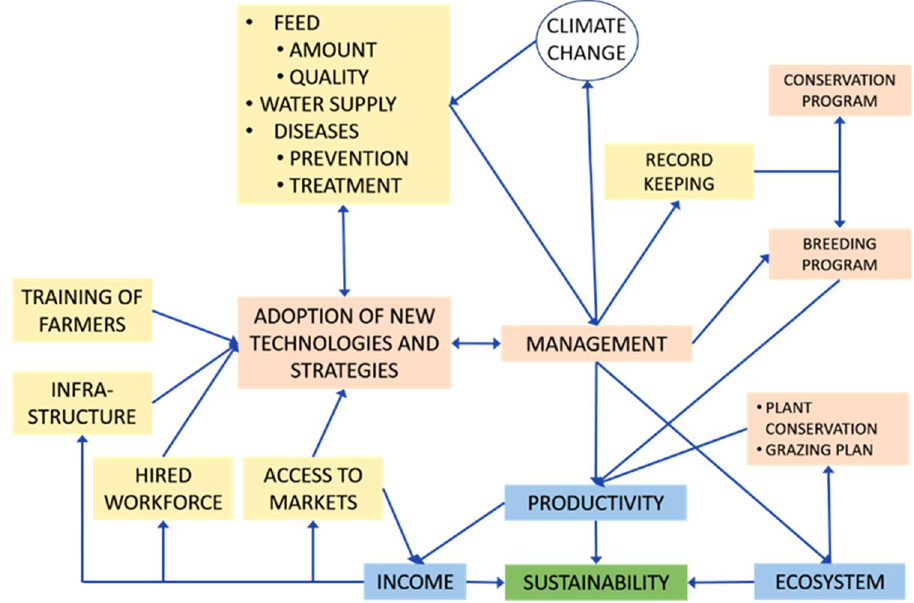
Fig. 3 Schematic diagram of interacting factors required to achieve sustainability in the Creole cattle production system in Pasorapa,